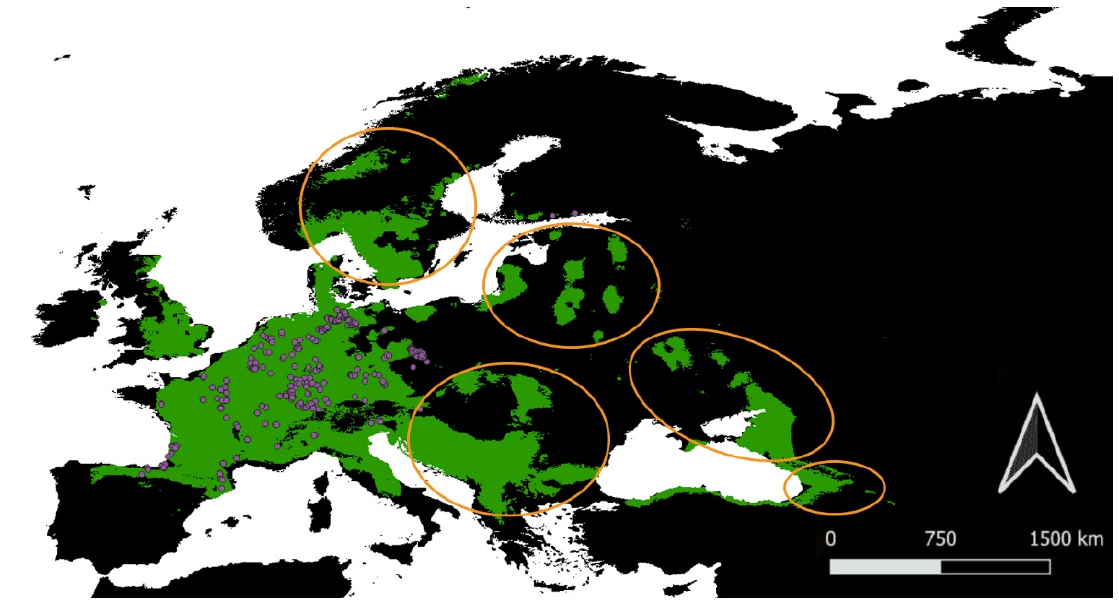
Figure 3. Predicted habitat suitability for Gnathotrichus materiarius under current climate conditions (green area), localities of known occurrence records (violet points), and crucial new potential sites that have not been colonised yet.